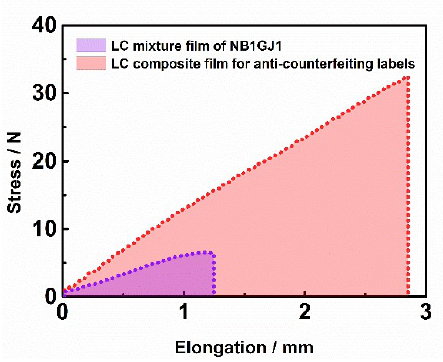
Figure 6. Peeling-strength results of the corresponding samples.